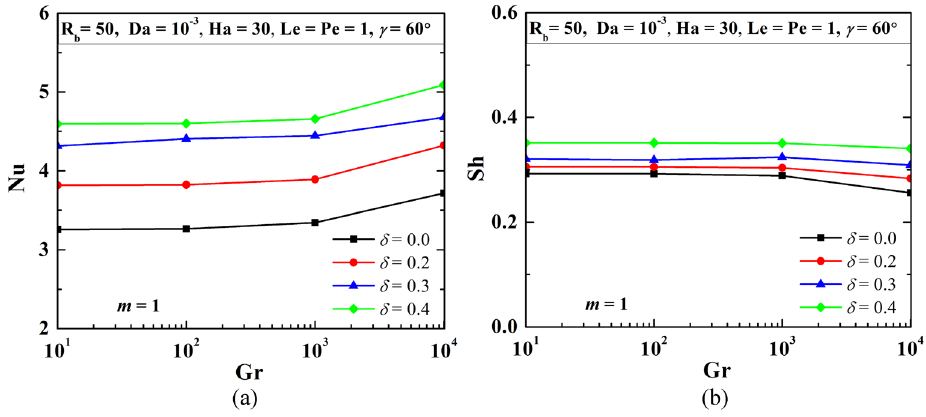
Figure 23. Variations of average Nu ( a ), and Sh ( b ) when R b = 50, Le = Pe = 1, Da = 10 –3 , Ha = 50, m = 1, δ = 0.3, γ = 60° varying Grashof number.